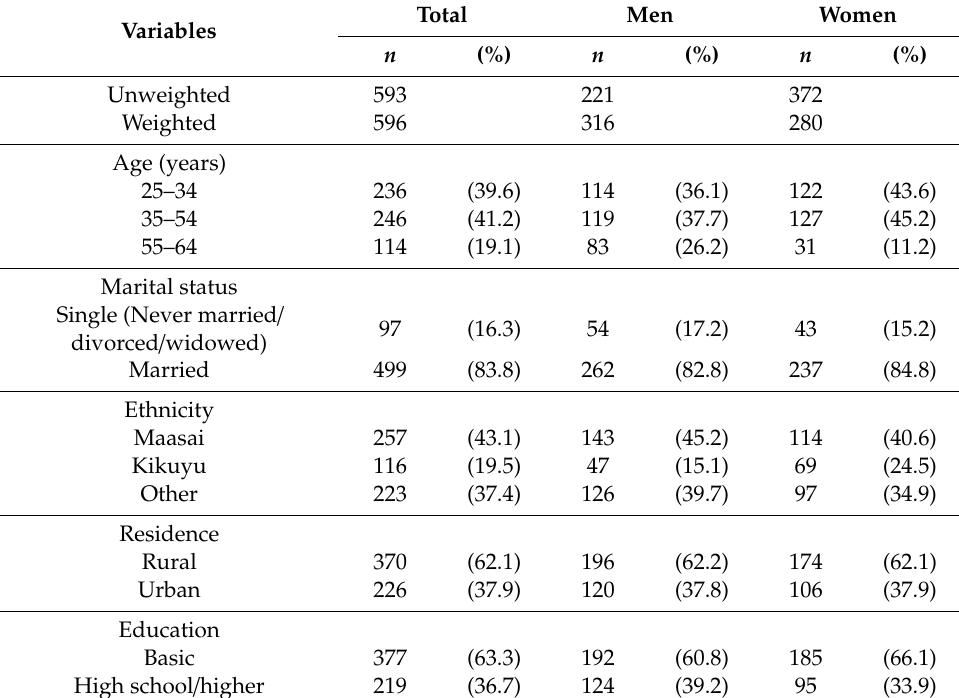
Table 1. Socio-demographic characteristics of participants segregated by sex among the residents of Kajiado County, Kenya. ( n =